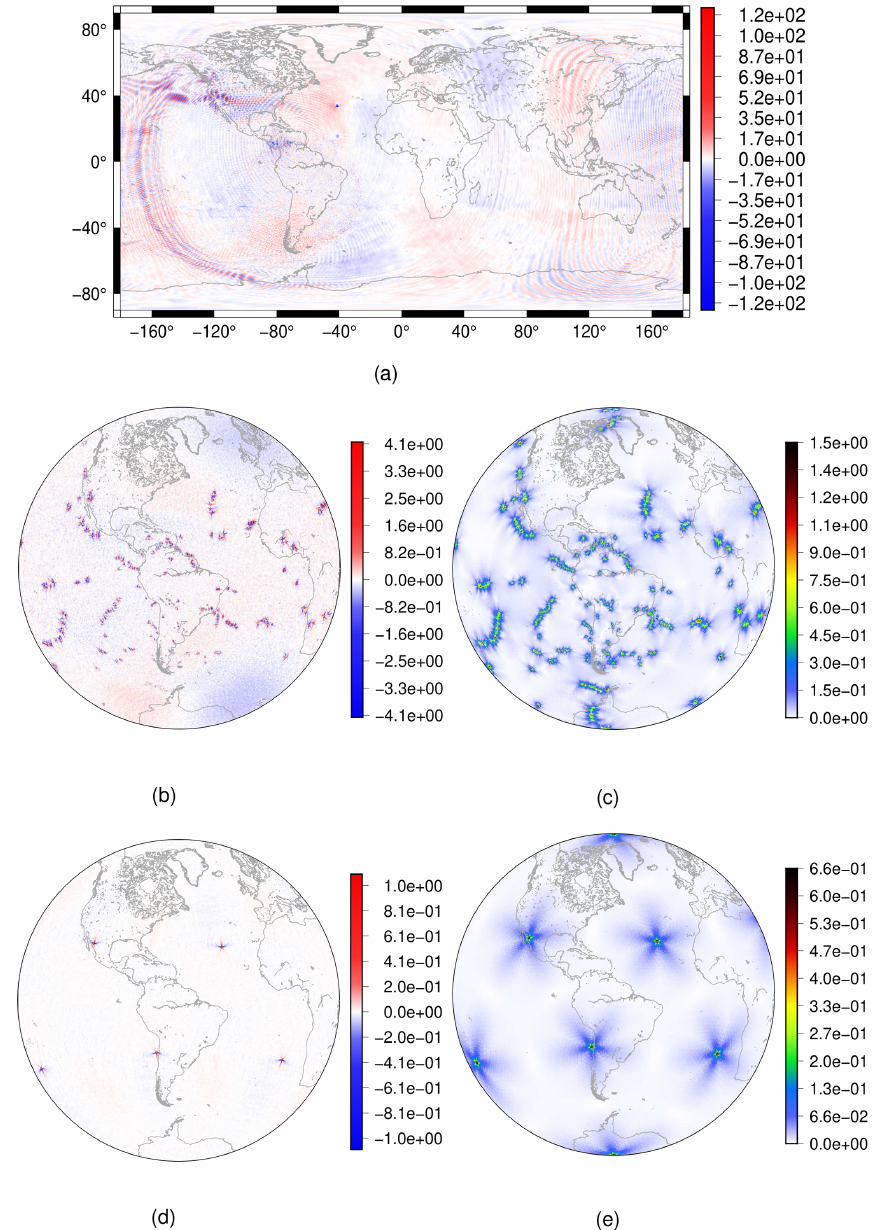
Figure 9. Steady geostrophic flow test case – plots for the VR7 grid: (a) height field error for each grid cell after 30d (without diffusion). (b) Height field error for each grid cell after 30d using numerical fourth-order hyperdiffusion based on the alignment index in the shallow- water model. (c) Grid alignment index (Peixoto and Barros, 2013). Plots for the UR7 grid: (d) height field error for each grid cell after 30d. (e) Grid alignment